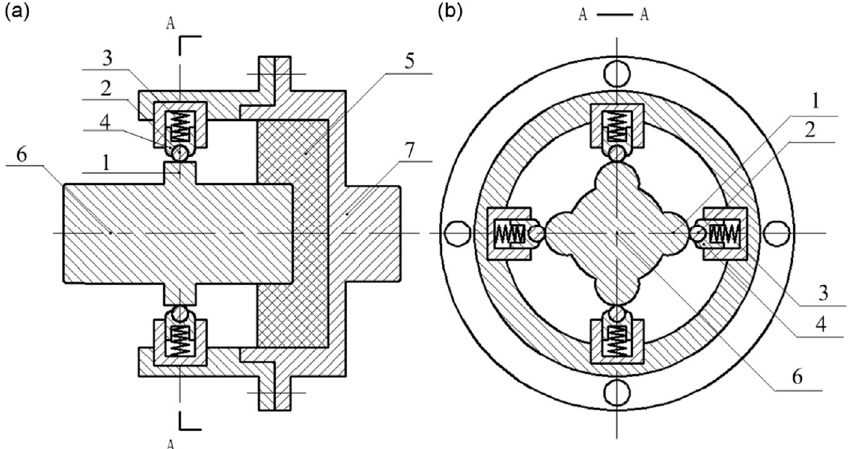
Figure 8. Schematic diagram of the QZS torsional vibration isolator. ( a ) Longitudinal-sectional view of the assembly, ( b ) cross-sectional view. Labels: 1-cam with radius r 2 , 2-roller with radius r 1 , 3-spring, 4-slider, 5-vulcanized rubber cam, 5-cylinder roller, 6-left shaft connector, 7-right shaft connector [58].